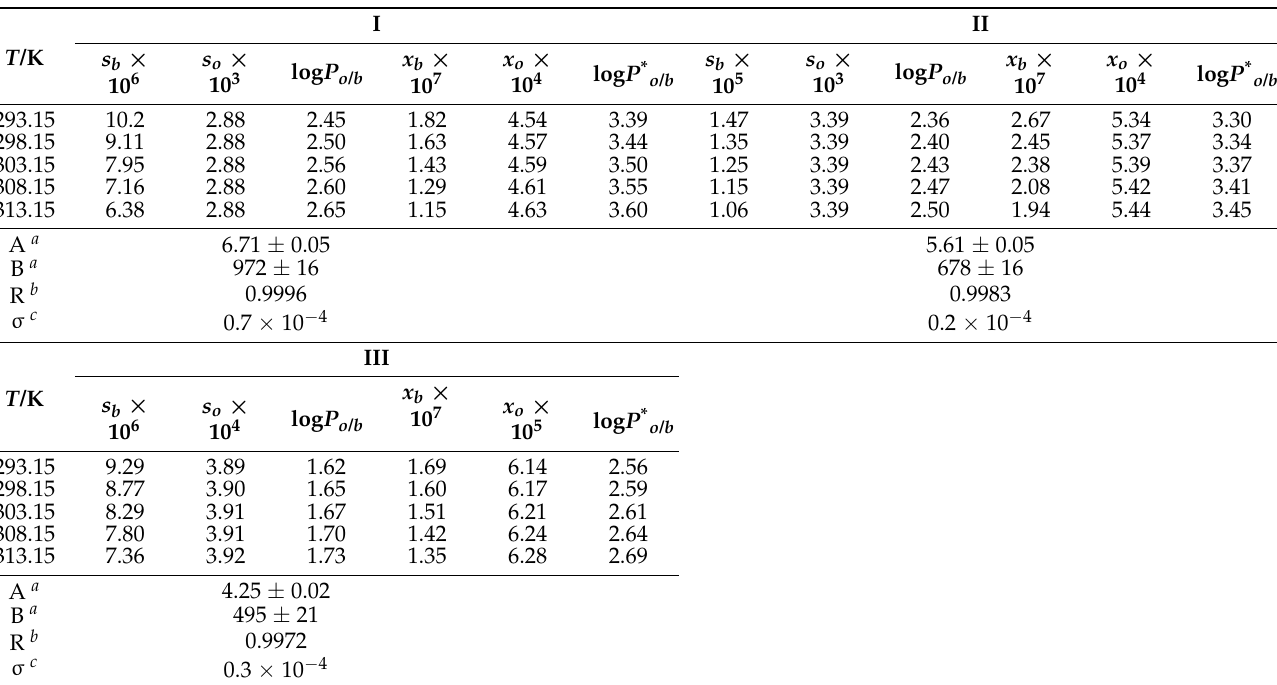
Table 5. Experimental concentrations ( s o , s b —mol · L − 1 and x o , x b —mole fraction in 1-octanol and buffer, respectively) and partition coefficients (log P o/b , log P * o/b —calculated by concentrations expressed in mol · L − 1 and mole fraction, respectively) for compounds studied in the system 1- octanol/buffer pH 7.4 at different temperatures and pressure p = 0.1